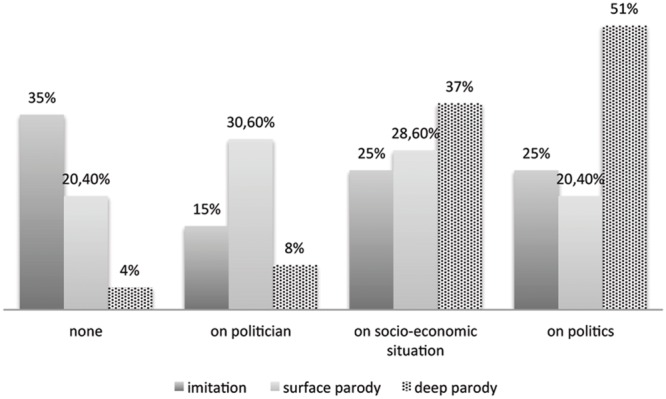
Target of distrust∗conditions.